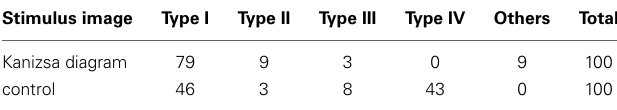
Table 1 | The frequency of network types for two stimulus patterns. theoretical maximum of the signal, and this value is common to